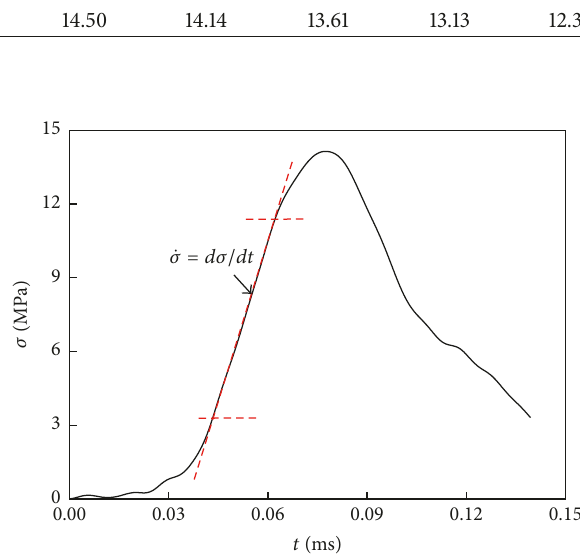
Figure4:Calculationmethodofloadingrateforthedynamictensile test.